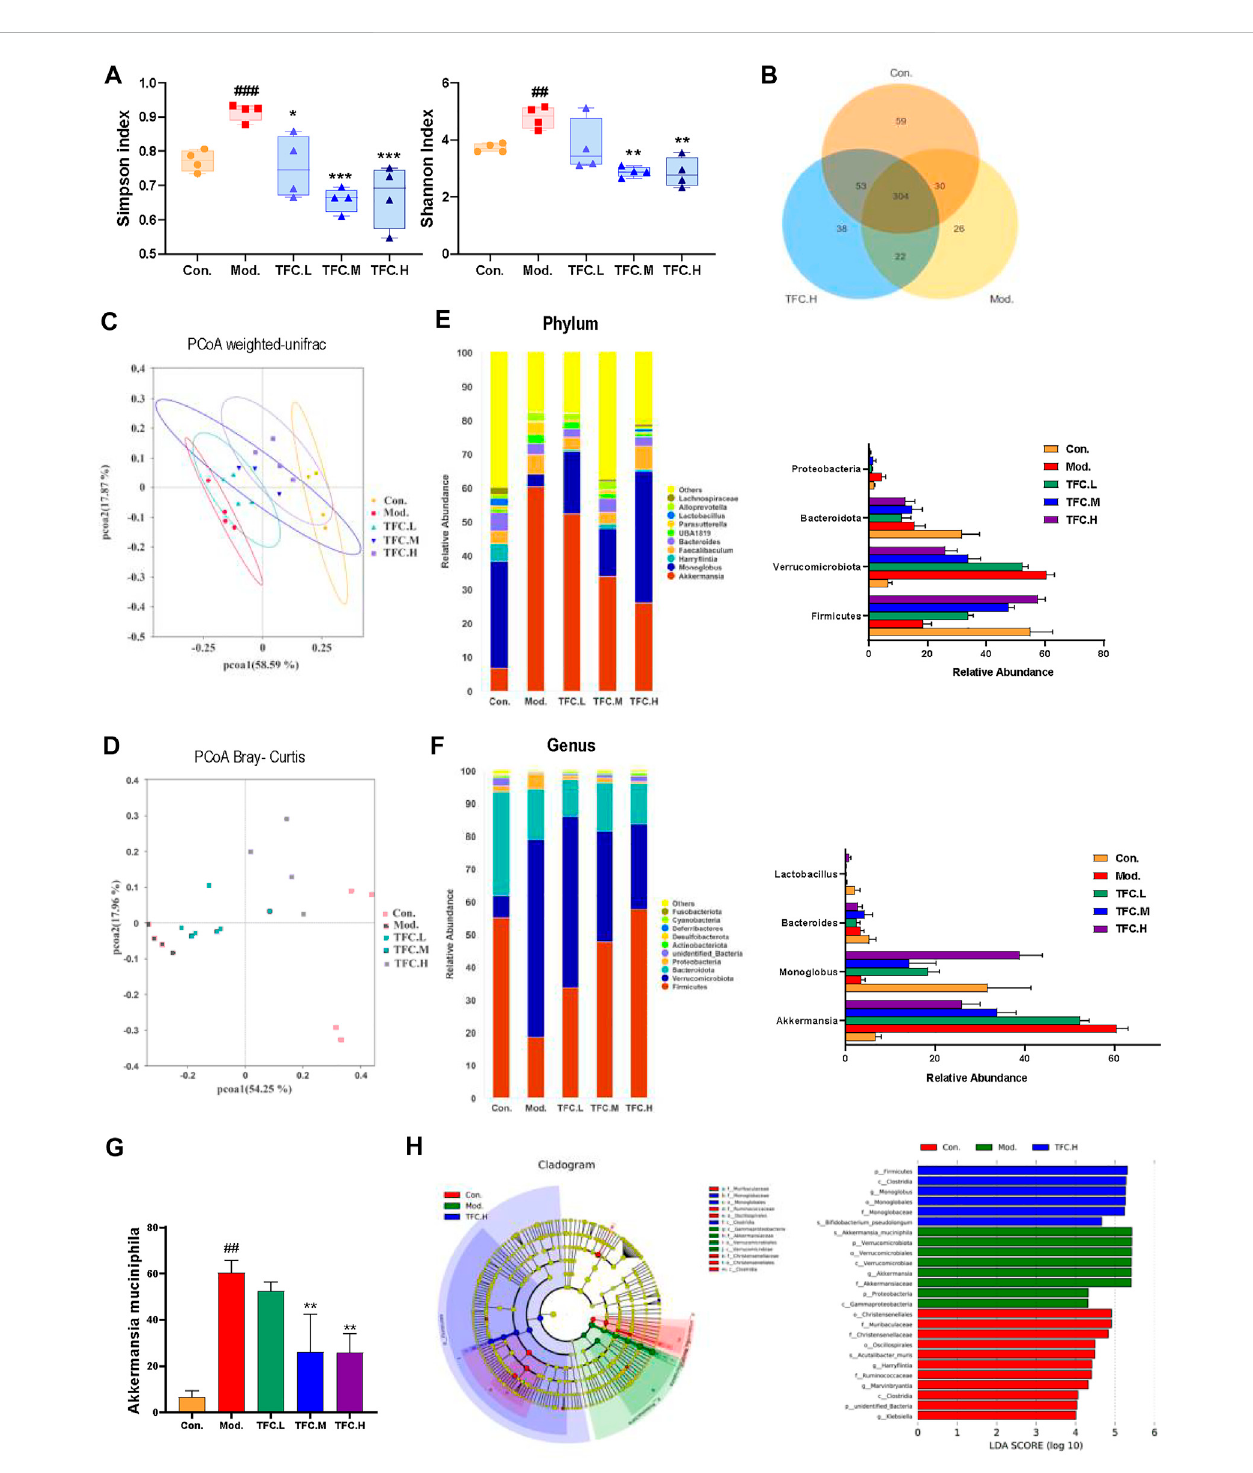
FIGURE 9 TFCregulatesthestructureandcompositionoftheintestinal fl ora (A) ShannonandSimpsonindicesofthegutmicrobialcommunitiesindifferentgroups (B) Venn diagrams illustrating the discrepancy of OTUs among the different groups (C) PCoA weighted-unifrac (D) PCoA Bray-Curtis (E) Composition of gut microbiota at the phylum level and the abundance of Firmicutes , Verrucomicrobiota , Bacteroidota and Proteobacteria (F) Composition of gut microbiota at thegenuslevelandtheabundanceof Akkermansia , Monoglobus , Bacteroides and Lactobacillus (G) theabundanceof Akkermansiamuciniphila (H) linear discriminant analysis (LDA) effect size (LEfSe) analysis was used to identify the most differentially abundant taxa of bacterial communities. Data are expressed as mean ± S.D. # p < 0.05, ## p < 0.01, ### p < 0.001 vs. control group; * p < 0.05, **p < 0.01, ***p < 0.001vs. model